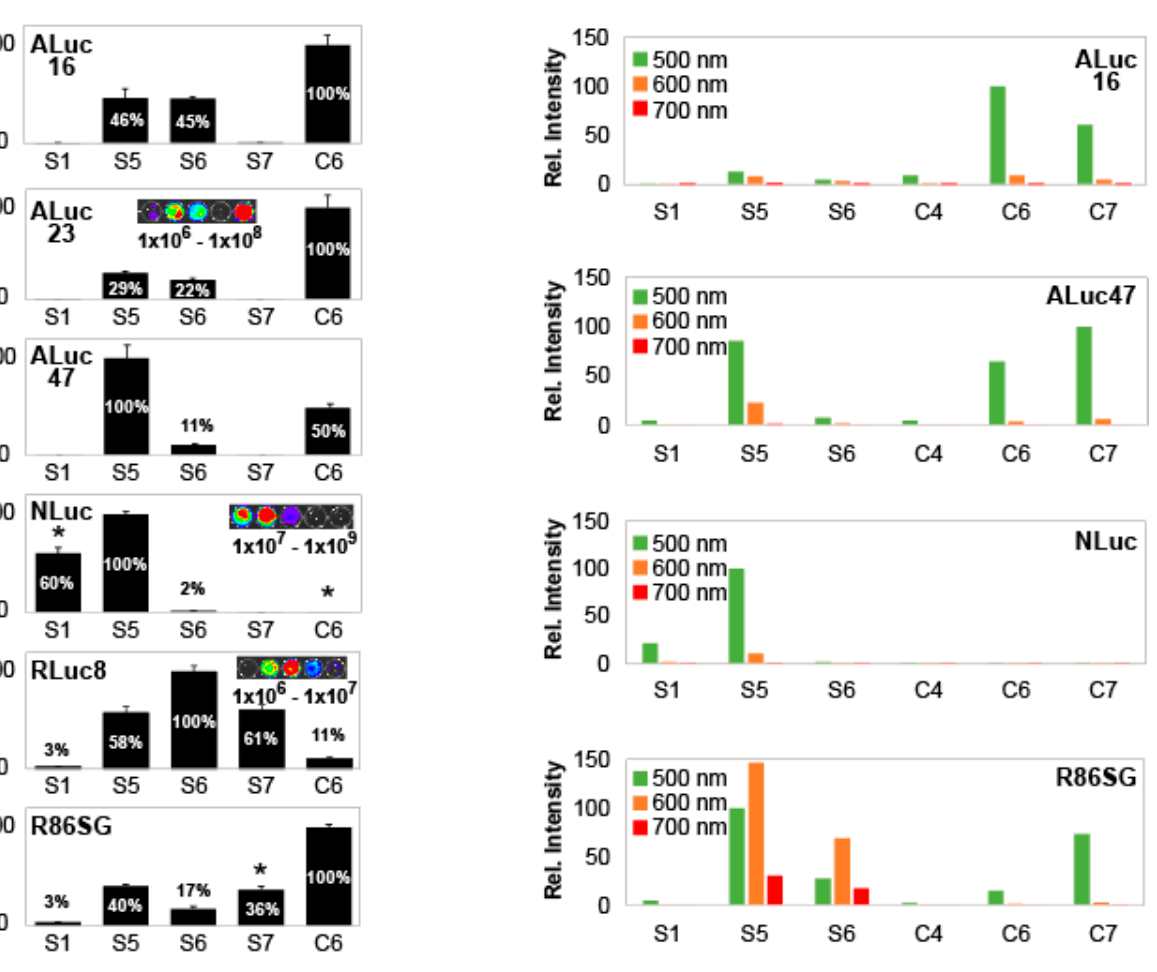
Figure 3. ( A ) BL intensity patterns of selected marine luciferases according to S-series CTZ analogues in living COS-7 cells. The BL intensities of various marine luciferases were normalized to show specific patterns. The asterisks highlight the characteristic features in the BL intensity patterns, different from the others. ( B ) Specification of the colors in the BL intensity patterns according to marine luciferases in living cells. The color intensities specified in the bar graphs were obtained with 500-, 600-, and 700-nm band-pass filters.